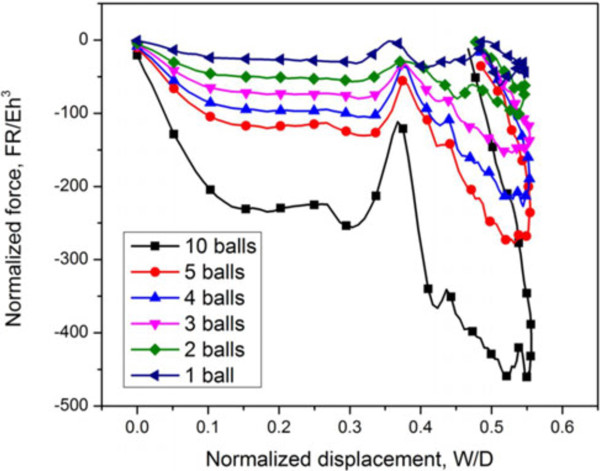
Characteristic normalized force-displacement curve of 1-D buckyball system with various numbers of horizontally lined C720buckyballs. The characteristic normalized force-displacement curve of 1-D buckyball system with various numbers of horizontally lined C720s at impact speed of 50 m/s.